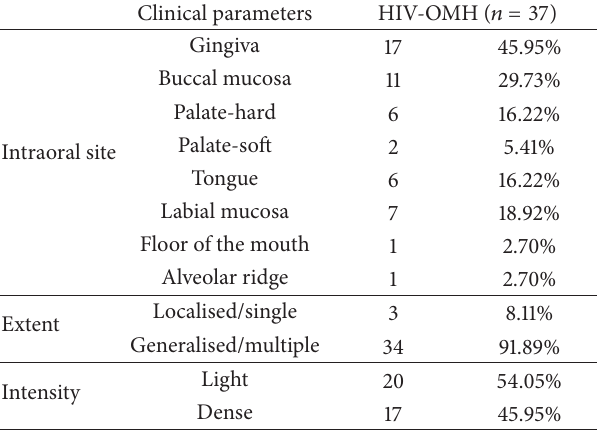
Table 2: HIV-OMH: sites affected and clinical characteristics . Clinical